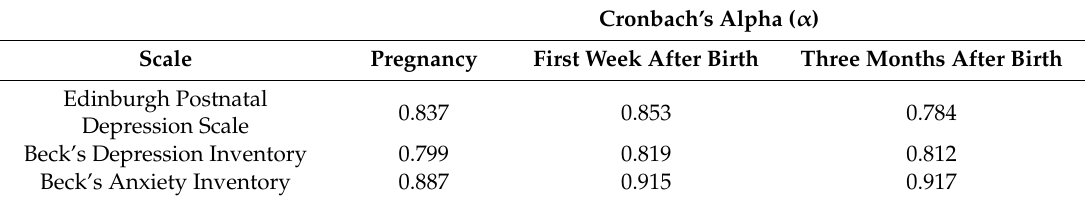
Table 1. Estimation of the reliability of a psychometric test.